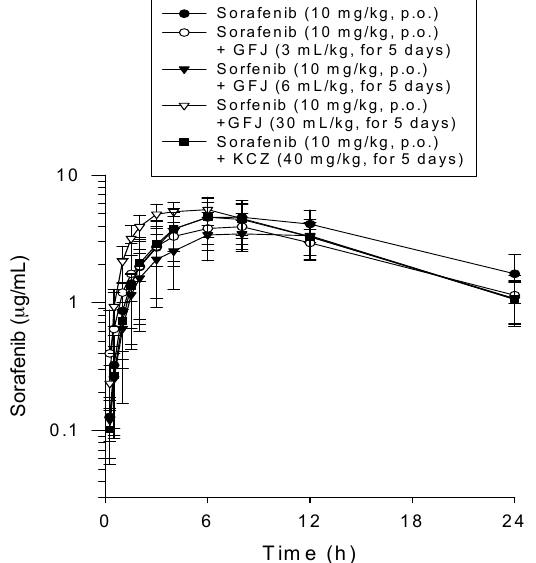
Figure 2. Time-concentration profiles of sorafenib in rat plasma following pretreatment with cytochrome P450 3A4 (CYP3A4) inhibitors of grapefruit juice and ketoconazole. Group A2 ( ● ): sorafenib (10